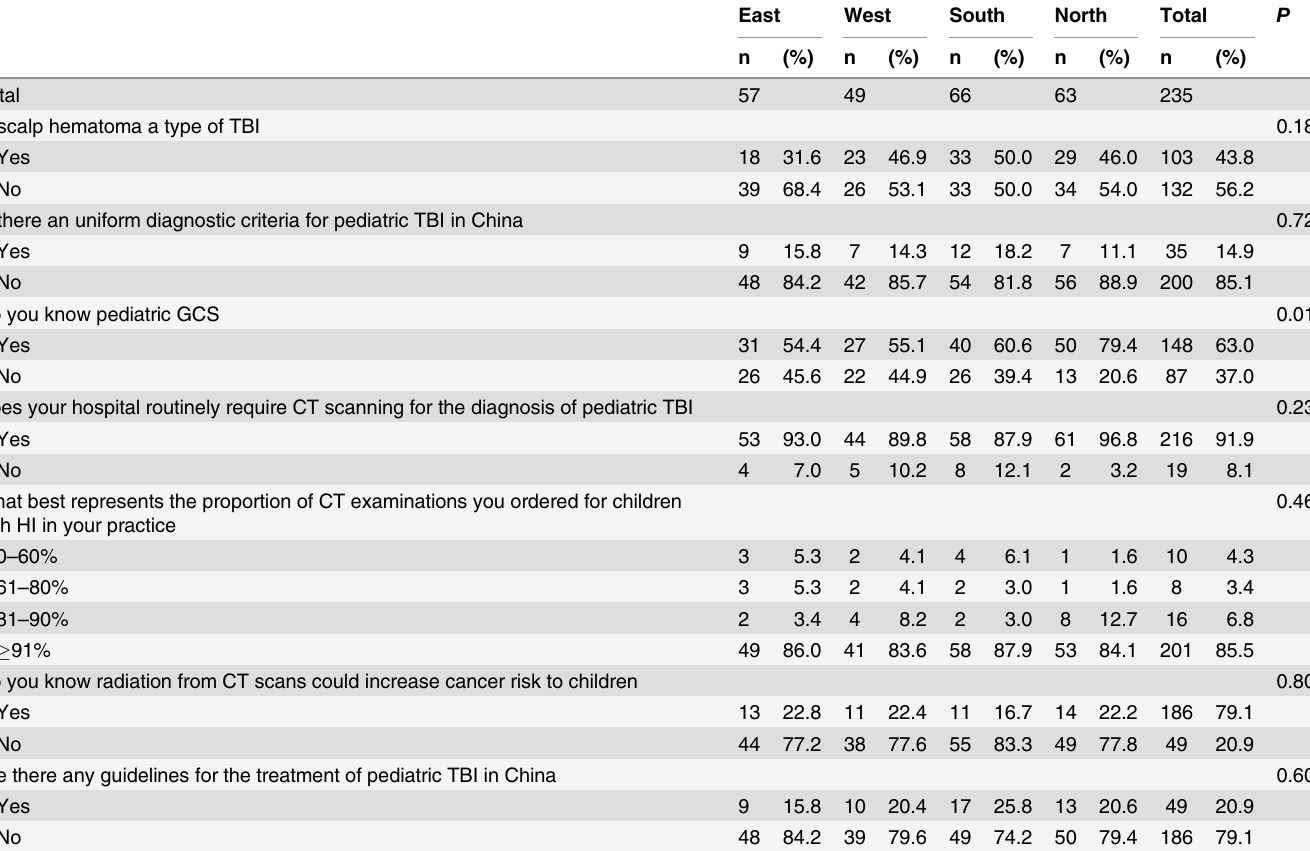
Table 2. Clinicians' Knowledge and Experiences of Pediatric TBI from 9 Large Hospitals in China Stratified by